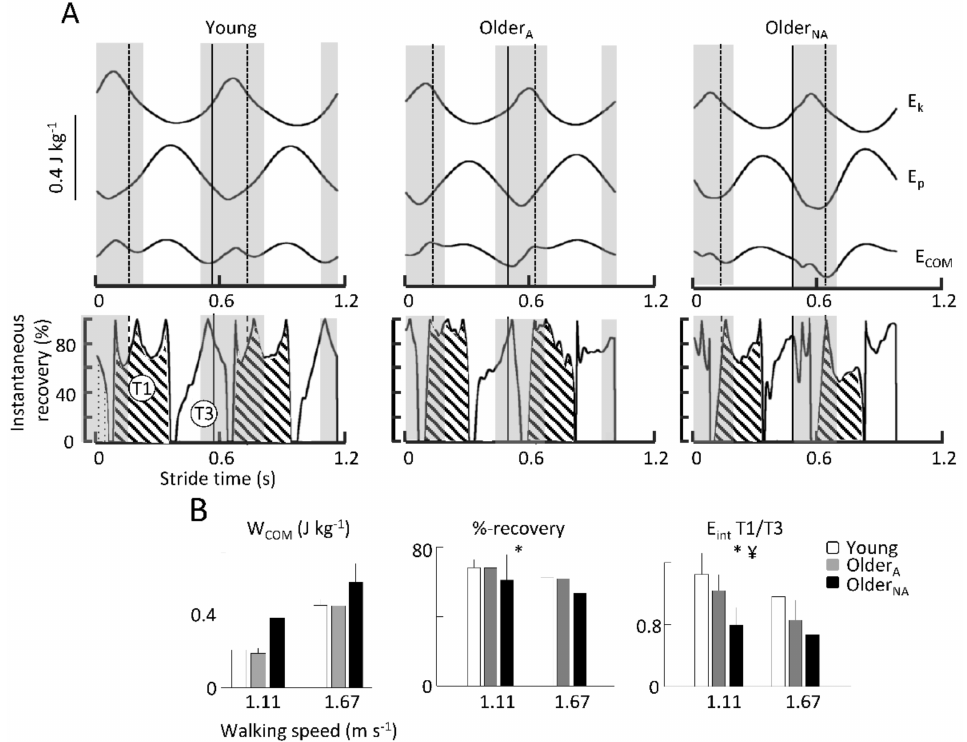
Figure 4. Pendulum mechanism of walking. ( A ) Typical traces of one representative stride of one subject in each group. Top panels: trace of the kinetic, potential and total energies of the COM during one stride during walking at 1.11 m · s − 1 . Middle panels: instantaneous recovery at each instant t of the same stride, varying from 0% when the E k and E p curves are in phase to 100% when the decrease in one curve equals the increase in the other. ( B ) Positive external work carried out over one stride (W COM ), average recovery during the stride (% recovery) and ratio between the absolute amount of energy saved during T1 and T3 ( E int T1/T3). The symbols * and ¥ indicate a significant effect of age and speed, respectively. Other indications as in Figure